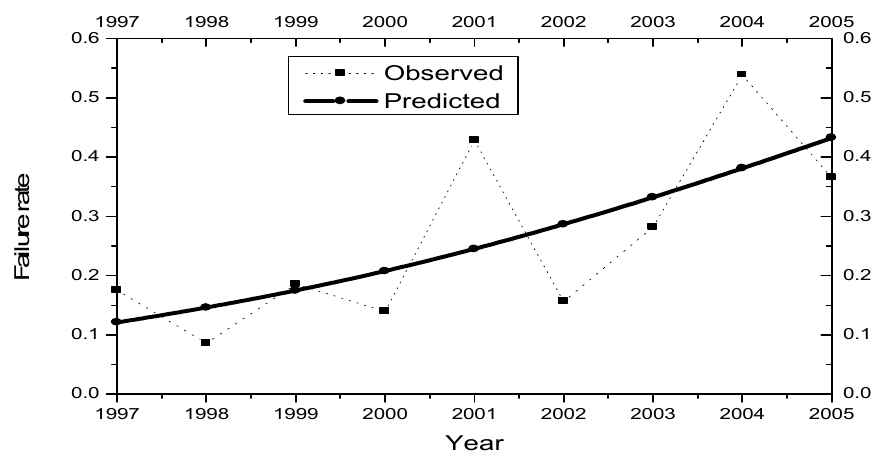
Figure 1 Observed and logistic regression predicted failure rates